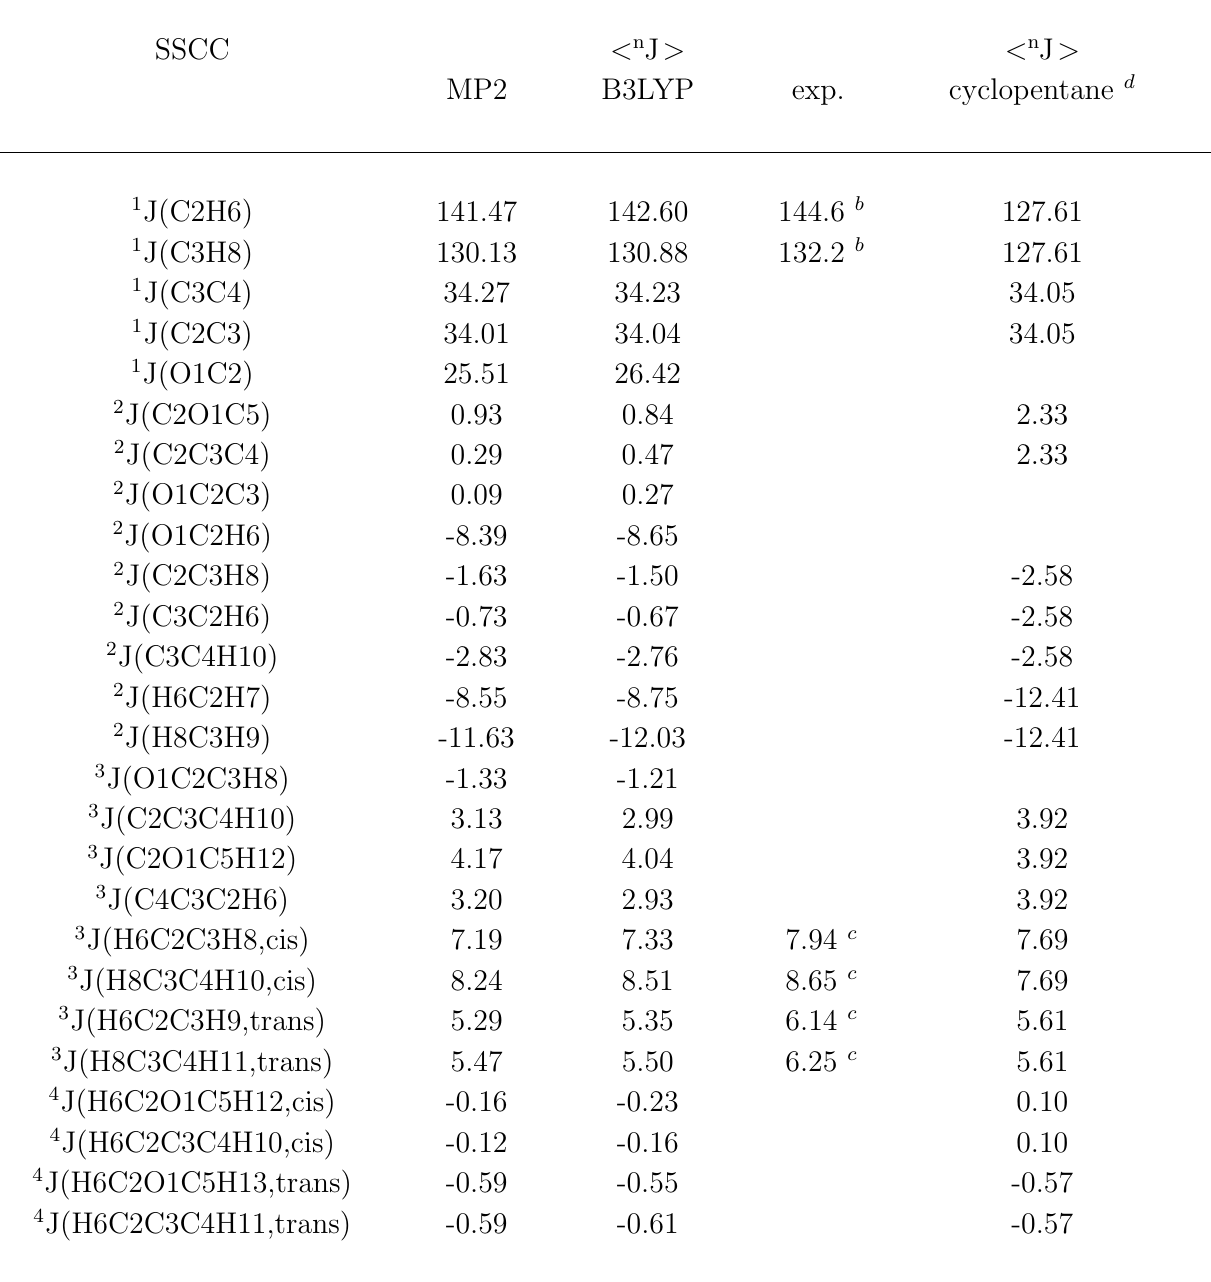
Table 5. Comparison of calculated and measured < n J > values of THF.